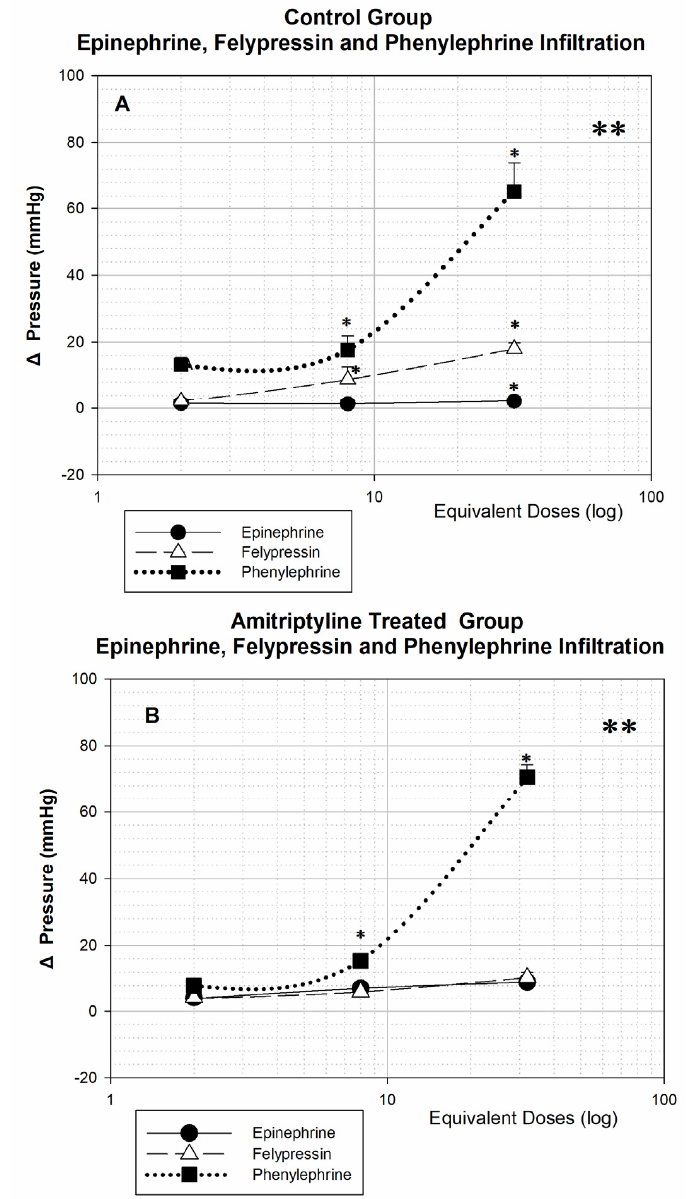
Figure 1. Variation in blood pressure ( Δ ) produced by infiltration of epinephrine, felypressin and phenylephrine at the vestibular sulcus of rats in the control group ( A ) (n = 7, for each vasoconstrictor) and treated with amitriptyline ( B ) (n = 7, for each vasoconstrictor) at equivalent doses to those present in 2, 8 and 32 tubes of local anesthetics with vasoconstrictors, adjusted for the average weight of the animals * p < 0.05; ** p <